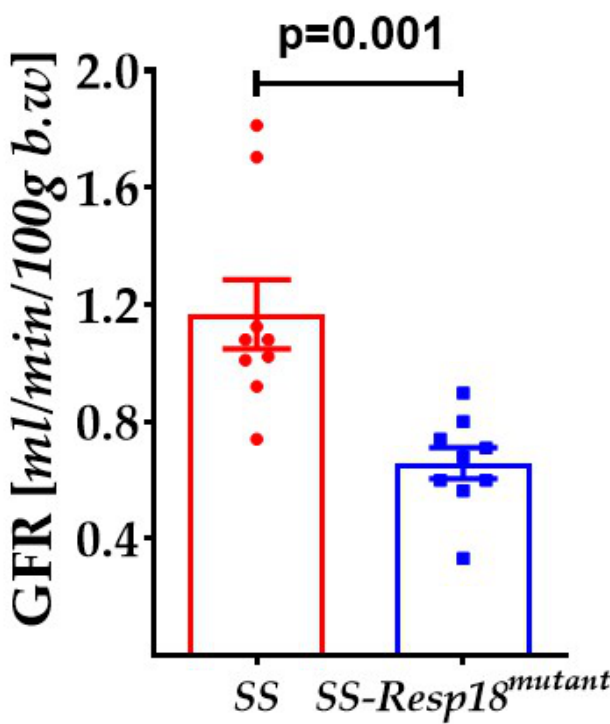
Figure 2. SS- Resp18 mutant rats have decreased GFR: SS and SS- Resp18 mutant rats were injected with FITC-sinistrin. The clearance of FITC-sinistrin in conscious rats was measured via the fluorescence detector NIC-kidney device placed on the rat’s back ( n = 8). Data are mean ± SEM. p = 0.001 vs. SS- Resp18 mutant rats, t -test.